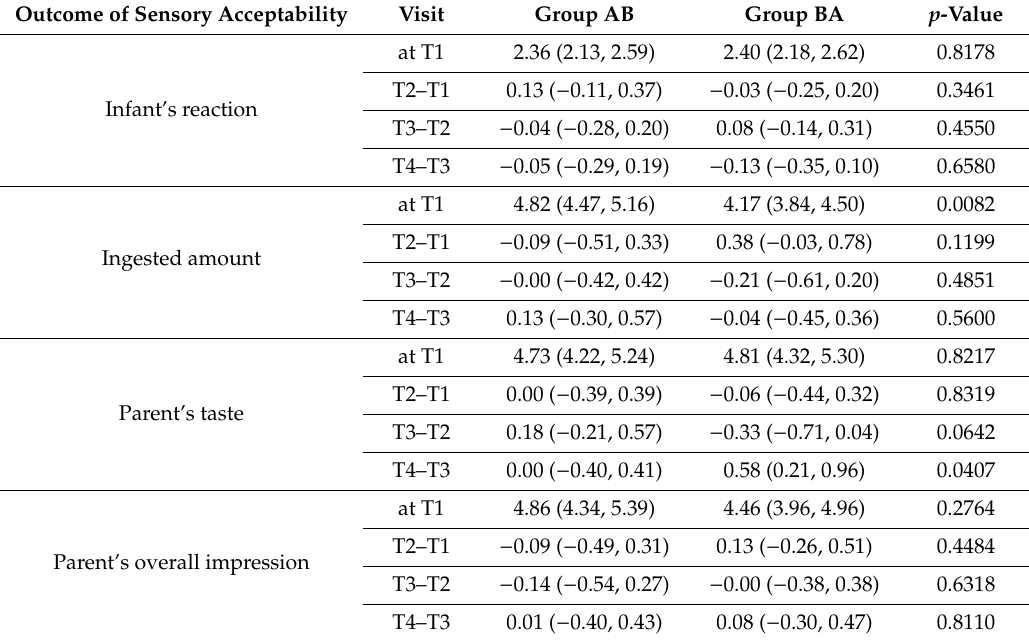
Table 3. Changes in variables for sensory acceptability between visits (infant’s reaction, food intake, parent’s taste and parent’s overall impression). T1: Initiation of first formula, T2: Follow-up of first formula, T3: Initiation of second formula, T4: Follow-up of second formula.